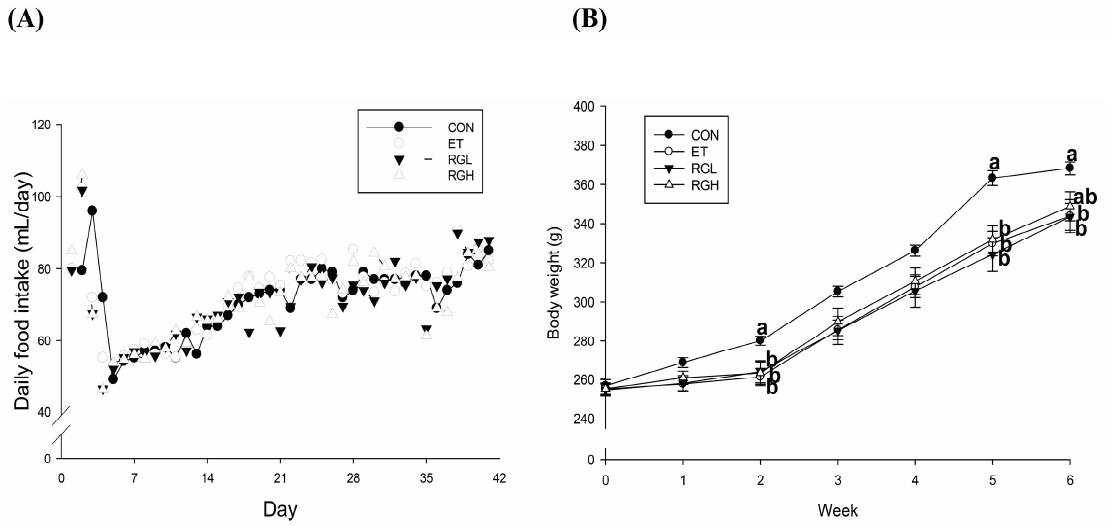
Figure 1. Changes in daily food intake ( A ) and body weight ( B ) in rats fed alcohol and KRG for 6 weeks: ( ● ) CON, normal control; ( ○ ) ET, ethanol control; ( ▼ ) RGL, ET + KRG 125 mg/kg body weight; ( ∆ ) RGH, ET + KRG 250 mg/kg body weight. Alcohol was provided at 5% of the Lieber-DeCarli liquid diet, and KRG was administered daily by gavage for the same time period. Data are expressed as the means ± SE ( n = 10/group). The values with the different letters are significantly different based on Duncan’s multiple range tests, p <